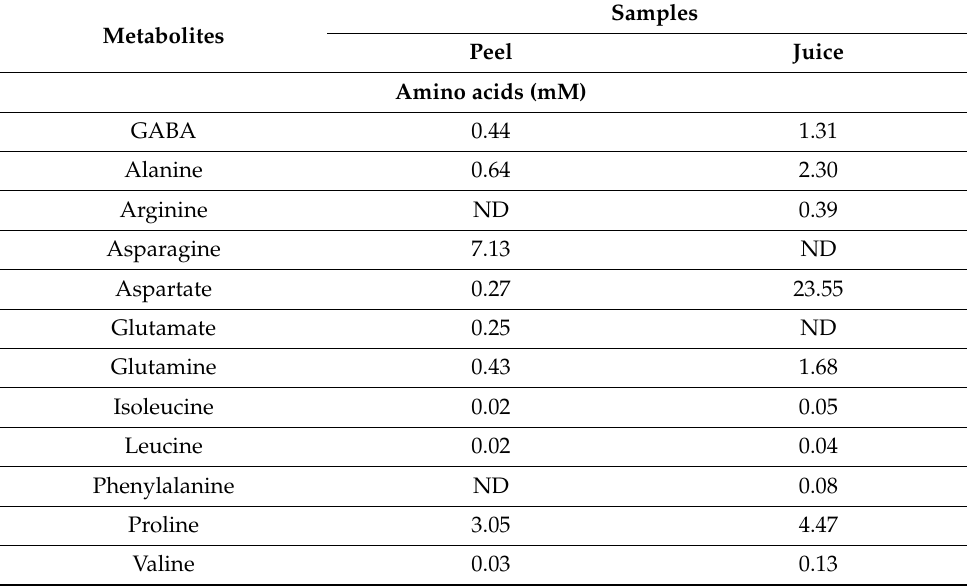
Table 2. Concentration of the metabolites identified for the different parts of the lemon fruit. The results correspond to the mean values ( n = 27) expressed in